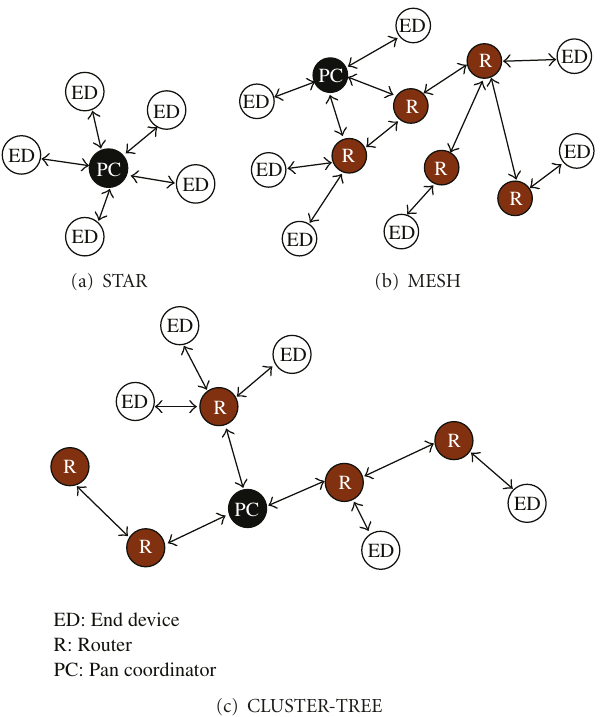
Figure 16: WPAN star, mesh, and cluster-tree network topologies.